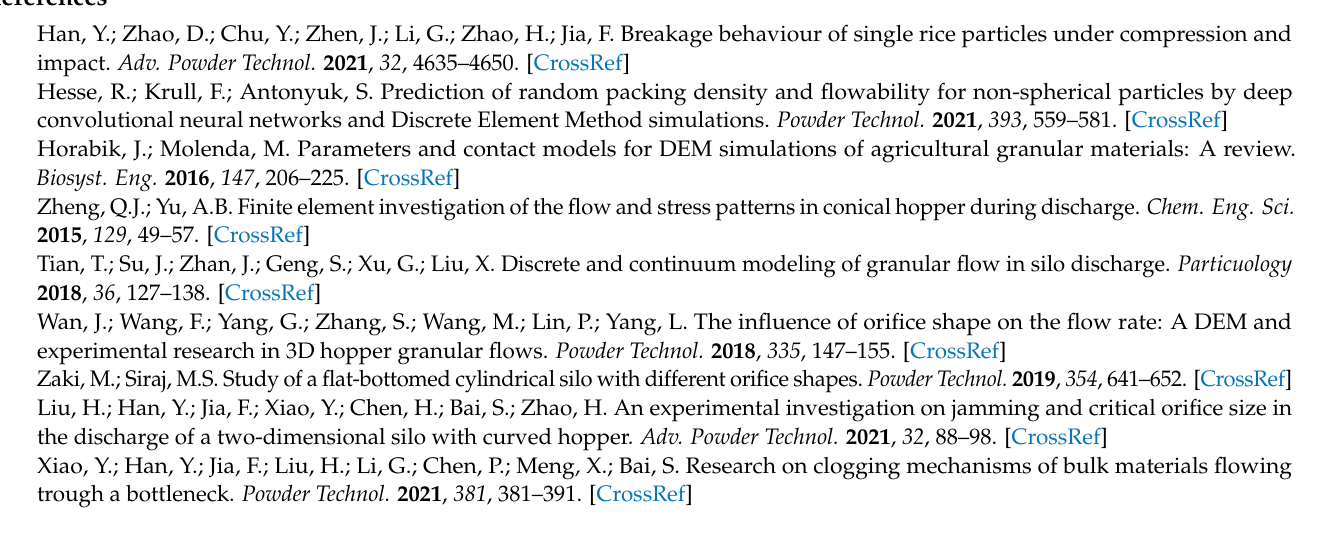
Figure S1: The process of discrete element modeling of rice seeds; Figure S2: The results of bench test and simulation test of natural rest angle for rice seeds with different moisture content: (a1–a6) are the results of natural rest angle of bench test, respectively, and its moisture contents are 10.23%, 14.09%, 17.85%, 21.77%, 26.41%, and 29.22%, respectively. (b1–b6) are the result of the natural rest angle of EDEM simulation, and its moisture content are 10.23%, 14.09%, 17.85%, 21.77%, 26.41%, and 29.22%, respectively. The red dotted line is the primary fitting curve; Figure S3: Rice seed accumulation partitioning diagrams: (a) and (b) are the two partitioning methods